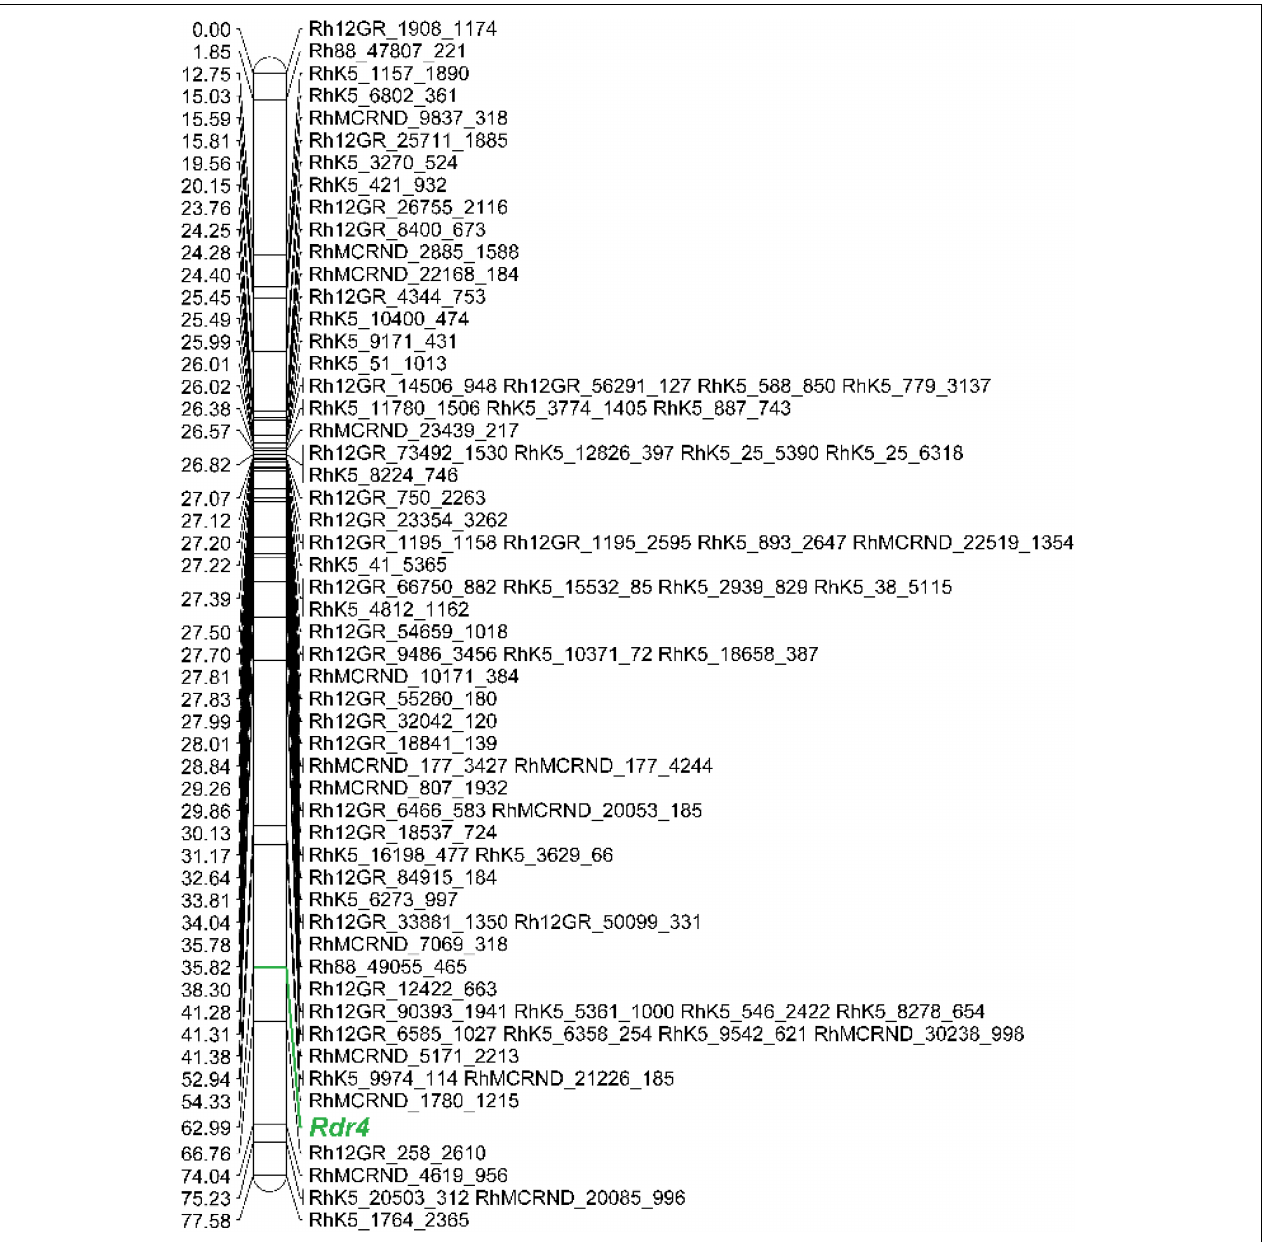
FIGURE 2 | The Brite Eyes TM chromosome 5 homoeolog 4 map. Rdr4 is displayed in green. This figure was produced using MapChart (v 2.3; Voorrips, 2002).